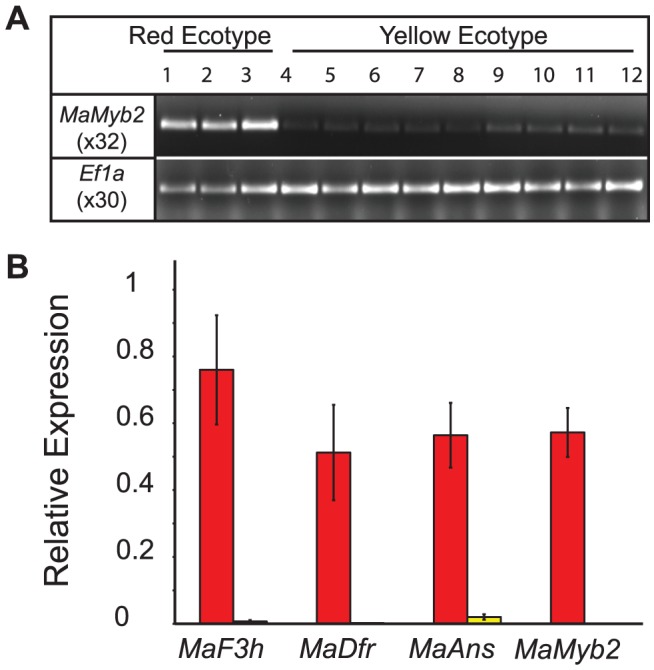
Gene expression is associated with genotype at MaMyb2.
(A) MaMyb2 floral expression is qualitatively associated with elevated floral anthocyanin content in red and yellow flowers collected from natural populations. PCR cycle numbers are listed below each gene. Ef1a is a constitutively expressed control. (B) In 18 F3 hybrids, gene expression segregates with genotype at MaMyb2 and is significantly higher in flowers that are RR (red bars) compared to YY (yellow bars) (FMaF3h
 (1, 16) = 16.76, P = 0.0008; FMaDfr
(1, 16) = 10.12, P = 0.006; FMaAns
 (1, 16) = 24.82, P<0.0001; FMaMyb2
 (1, 16) = 48.00, P<0.0001). Error bars indicate one standard error.